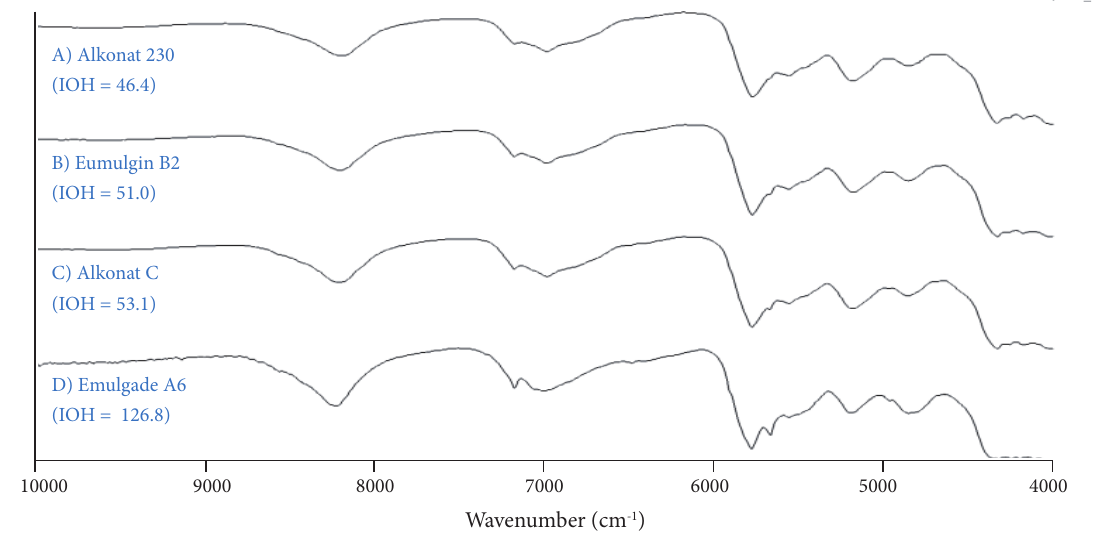
Figure 6. FT-MIR reflection analysis spectra of surfactants analyzed as